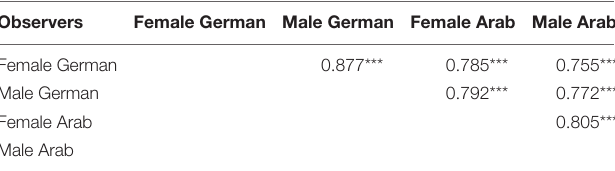
TABLE 2 | Pearson’s product moment correlations for average rapport ratings across 20 dyads. Observers